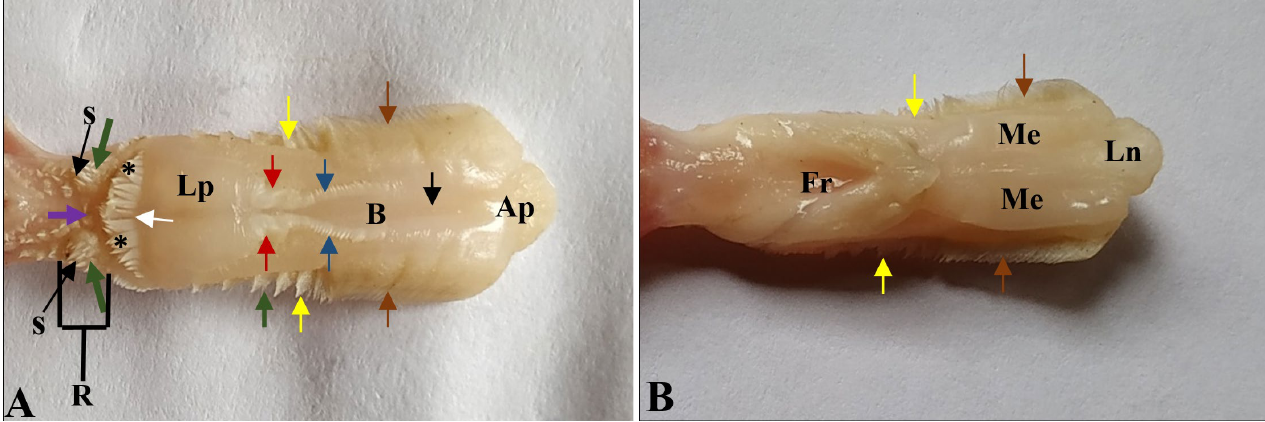
Fig. 2. Photographs of the dorsal (A) and ventral (B) surface of the tongue of the Khaki Campbell duck on day one showing the apex of the tongue (Ap), the body of the tongue (B), median groove (Black arrow), lingual prominence (Lp), lingual comb (Blue arrow), turned up lingual comb (Red arrow), conical papillae on the caudal border of the lingual prominence (Black star), mucosal elevation (White arrow), Small conical papillae (orange arrow), large conical papillae (Yellow arrow), filiform papillae (green arrow), the root of the tongue R), mucosal swellings (S), median ridge (Purple arrow), attachment of the frenu-